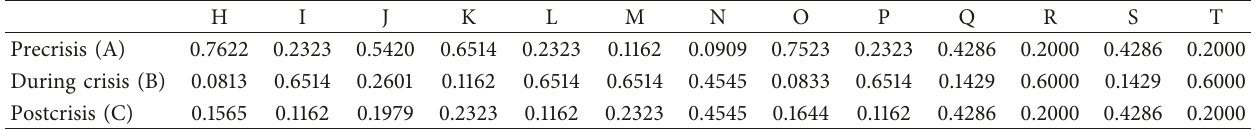
Table 11: Overall priority coefficient of alternatives based on each